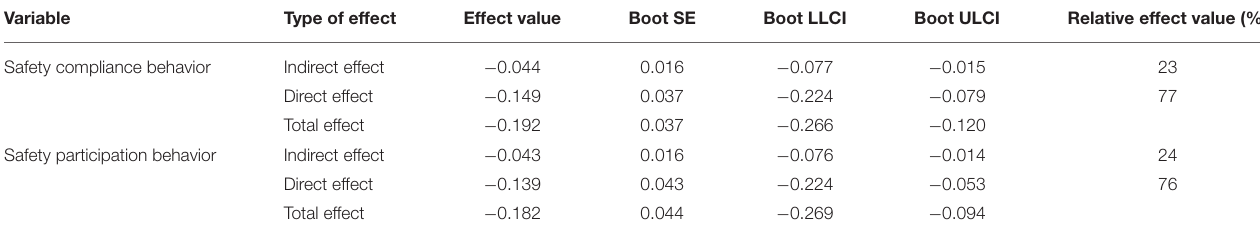
TABLE 4 | Decomposition of indirect, direct and total effects.